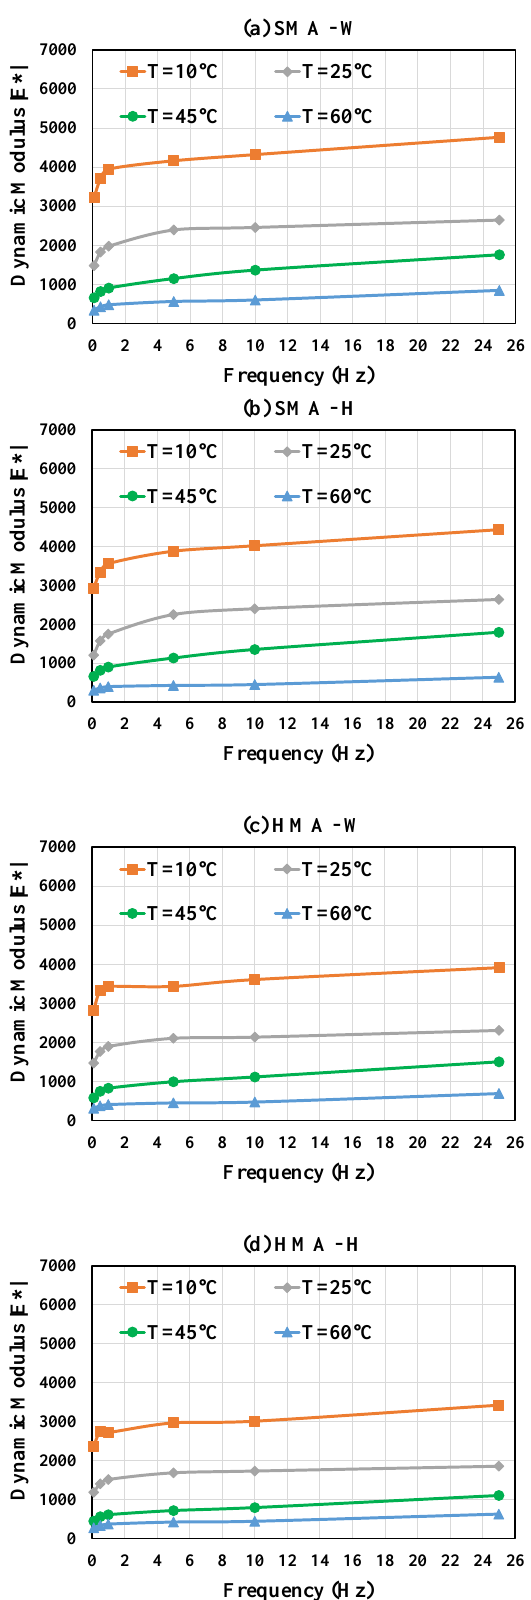
Figure 4. Experimental results of dynamic modulus | E* | in function of the frequency, in the case of ( a ) SMA-W; ( b ) SMA-H; ( c ) HMA-W; and ( d ) HMA-H.